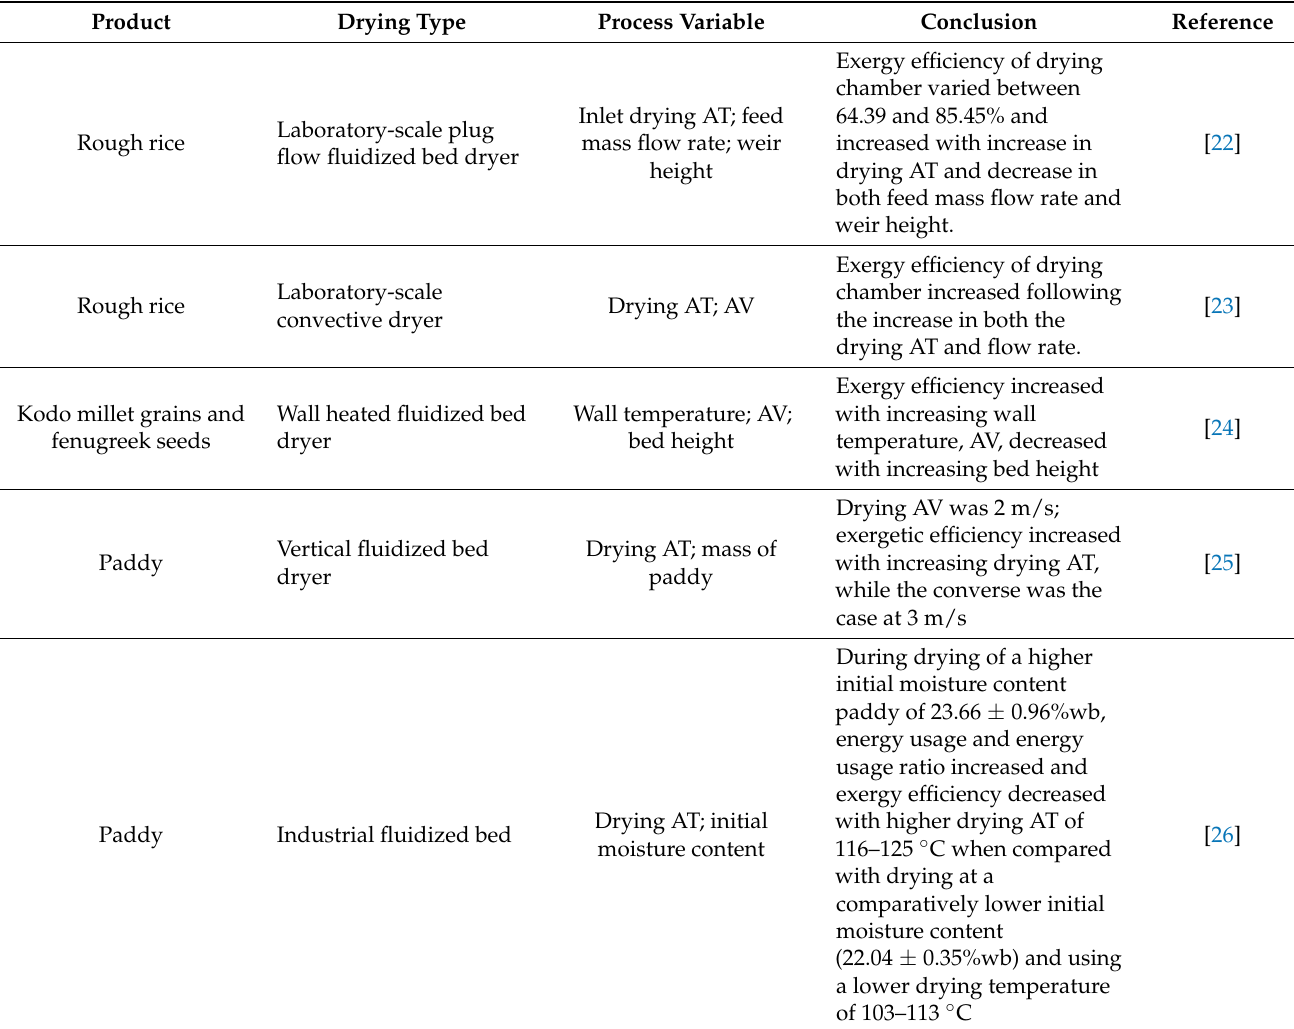
Table 1. Studies on the effect of drying process variables on exergy efficiency in the drying process and their